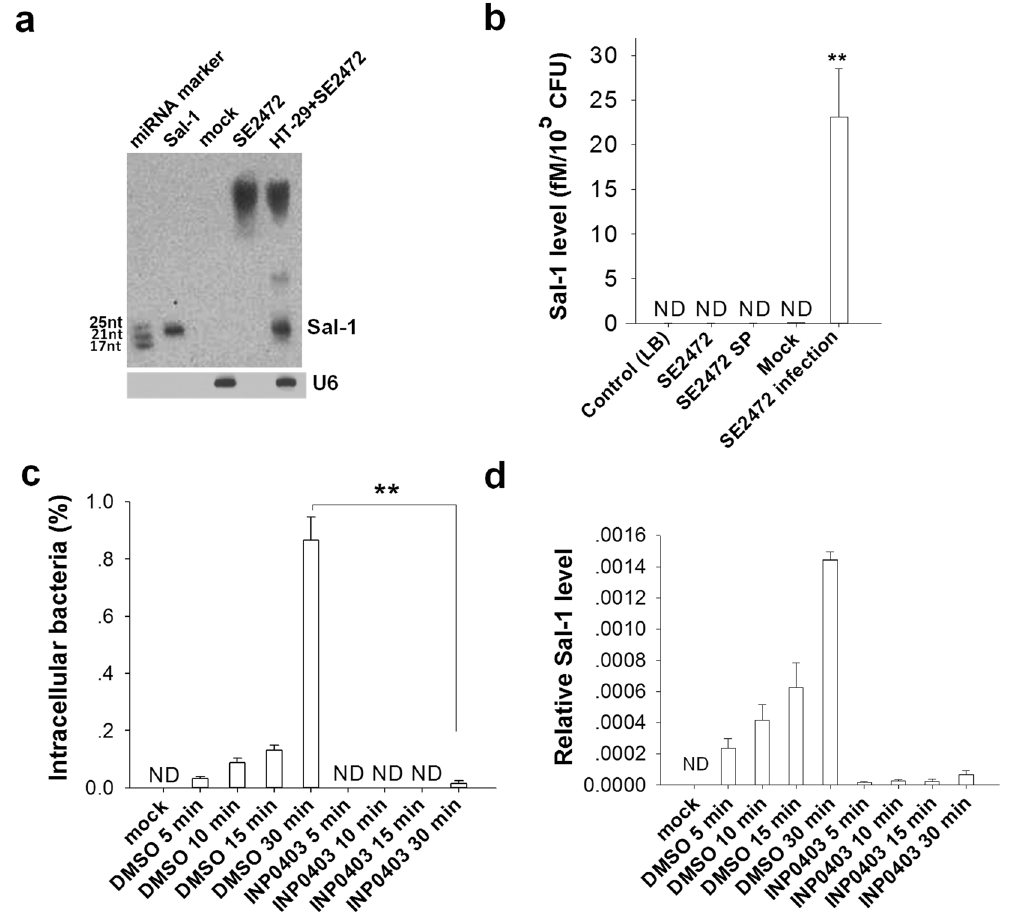
supernatant (SP) and HT-29 cells with Mock or SE2472 infection. ( c - d ) Bacteria number ( c ) and Sal-1 level ( d ) in the SE2472-infected HT-29 cells treated with or without T3SS blocker INP0403. The data are presented as the mean ± SEM (n = 4). ND, not detected. ** P <